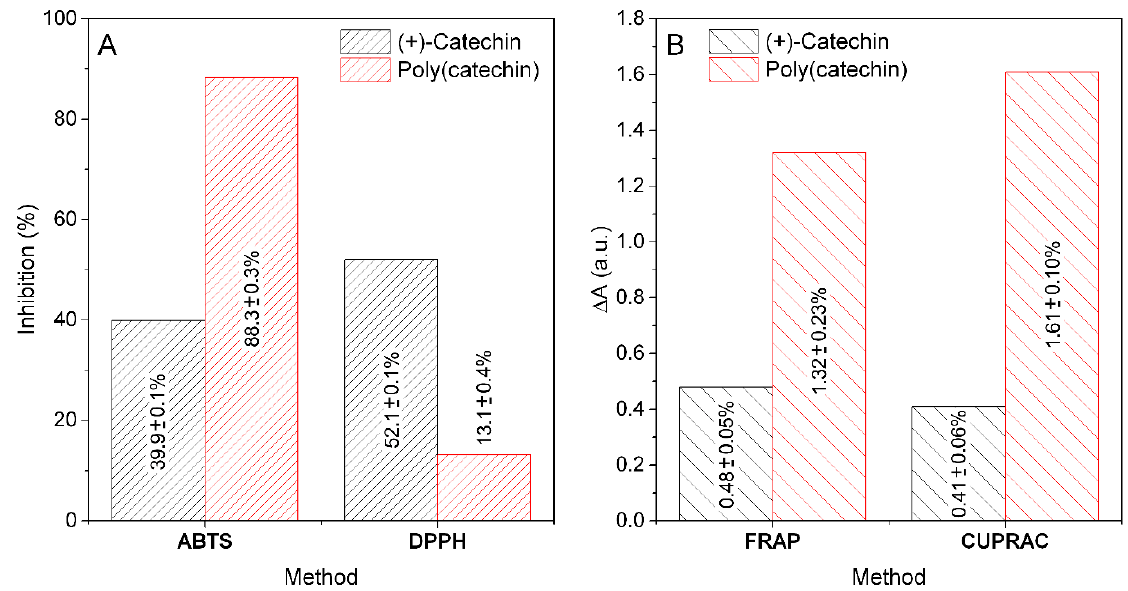
Figure 5. Ability of 0.1 mg/mL (+)-catechin and poly(catechin) to reduce free radicals ABTS and DPPH ( A ) and for reduce of iron and cupric ions measured by FRAP and CUPRAC methods ( B ).